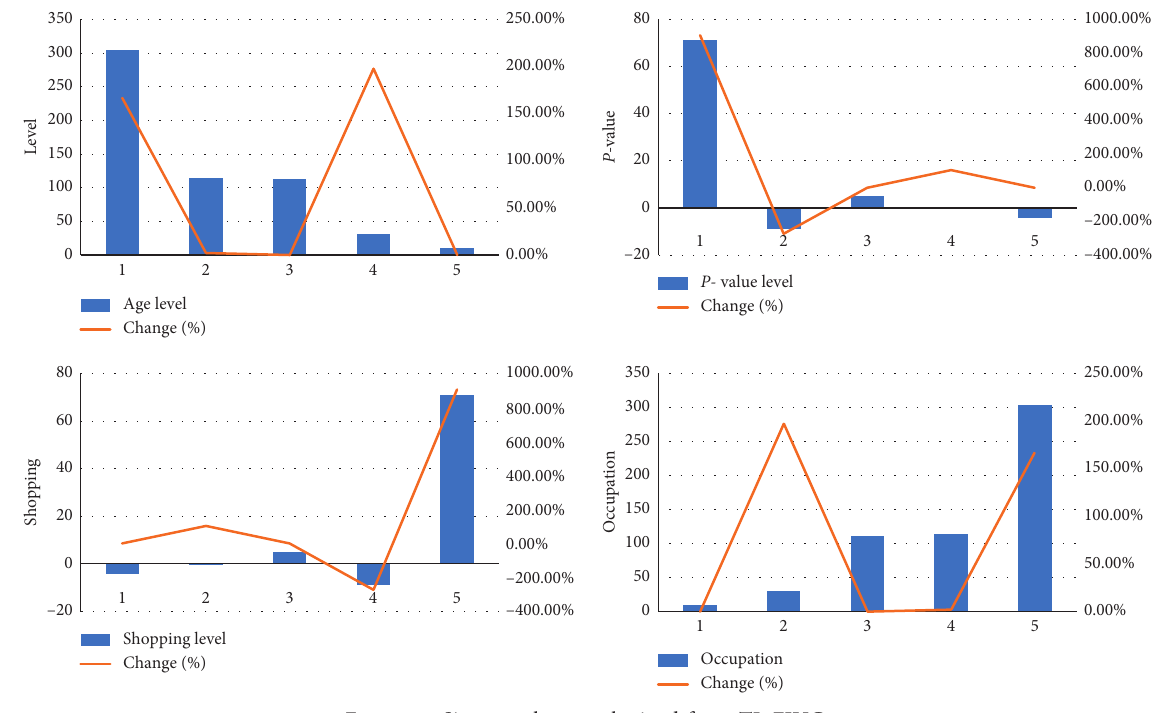
Figure 5: Six central users obtained from TL-FIUC.